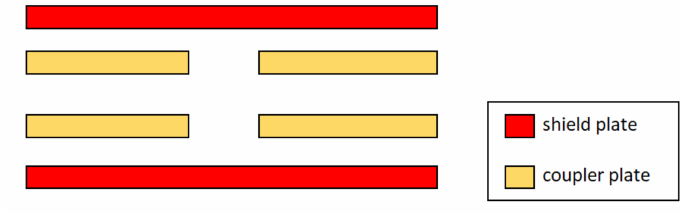
Figure 1. Four-plate couplers with shielded